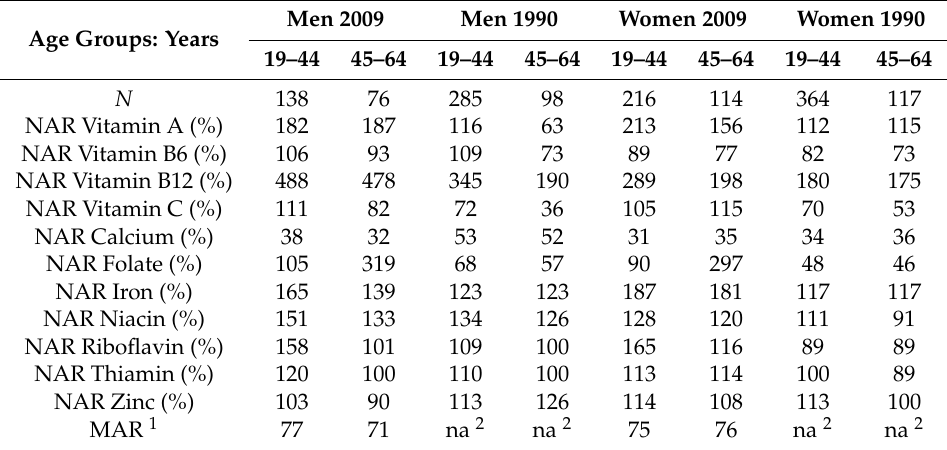
Table 3. Mean nutrient adequacy ratios (NARs) of micronutrient intakes in 19–64-year-old men and women, in 2009 and 1990 [10].